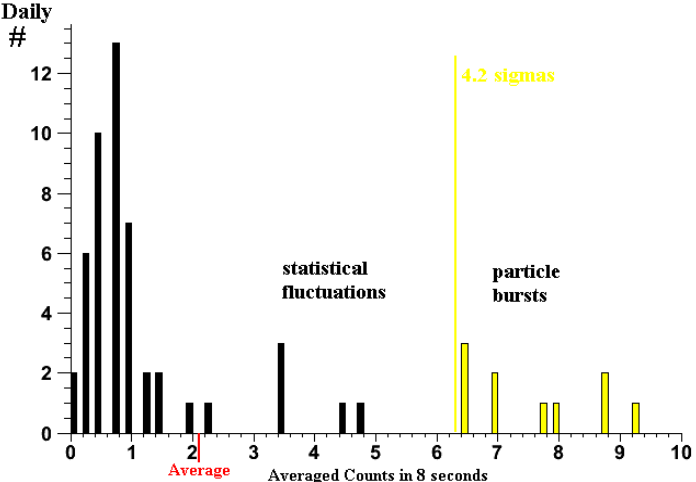
Figure 3. CR distribution in the green cell of Figure 2, where 1.1 < L < 1.2, 90° <  < 105° and 22.0  < B <  . As the CR was the average of 4 CRs in 8 seconds, the fractional values and significance must be redefined [25]. To have <1% probability to be a poissonian fluctuation, CRs must exceed the 4.2 sigmas